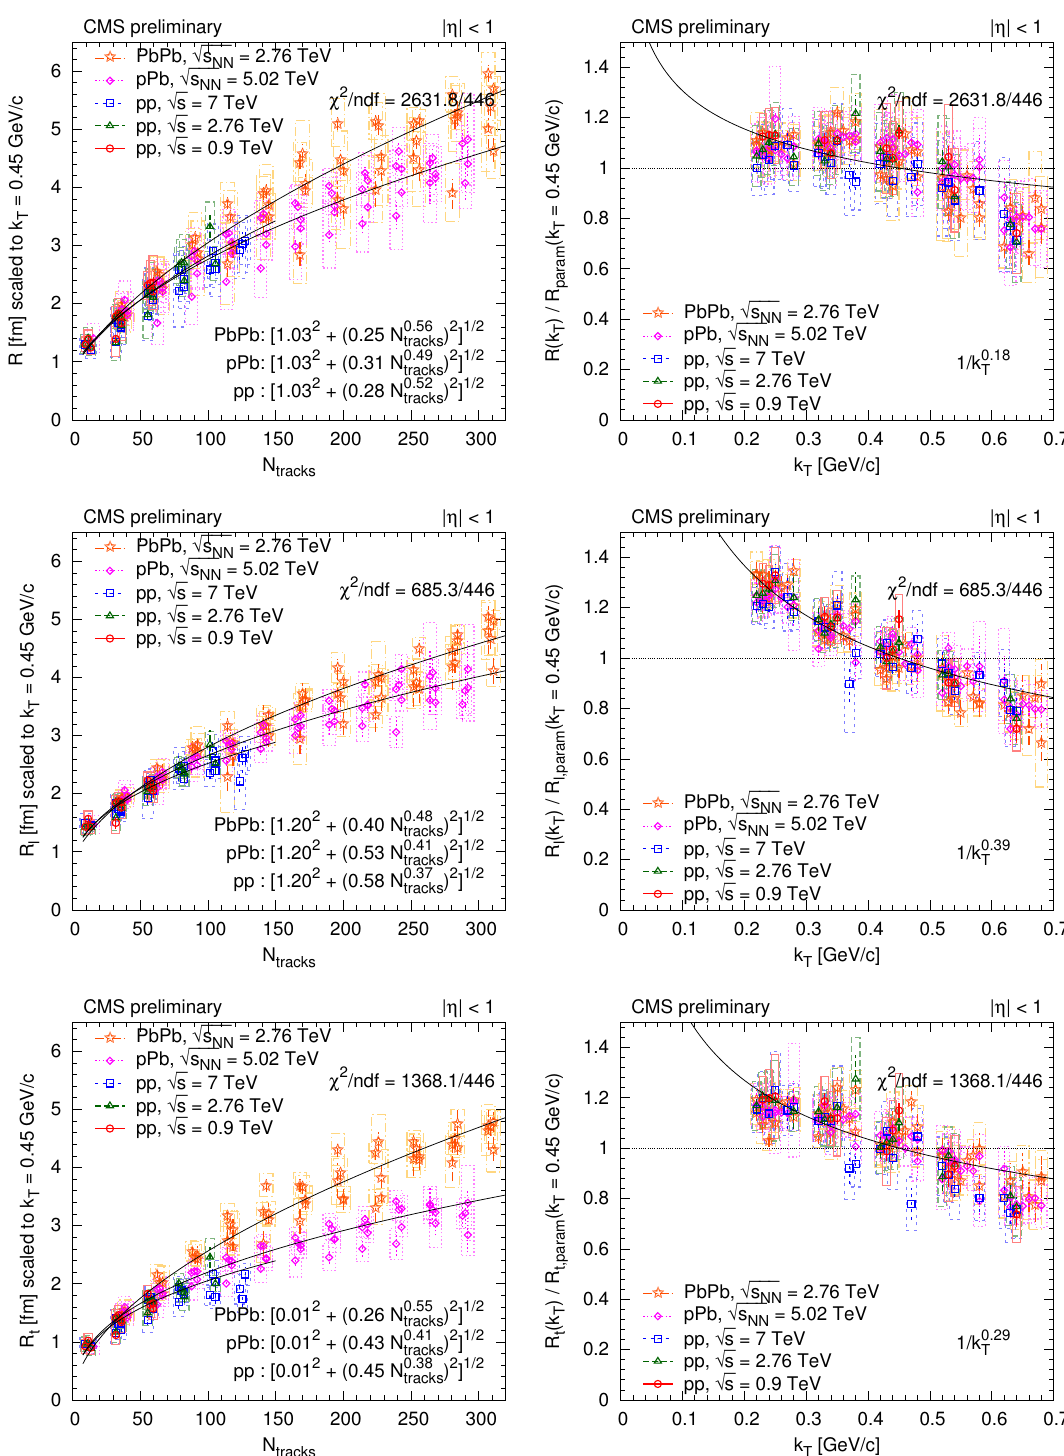
Figure 7. ( Left ) Radius parameters as a function of N tracks scaled to k T = 0.45 GeV/ c with the help of the parametrization R param (Equation 5). ( Right ) ratio of the radius parameter and the value of the parametrization R param (Equation 5) at k T = 0.45 GeV/ c as a function of k T (points were shifted left and right with respect to the center of the k T bin for better visibility). Upper row: R from the one-dimensional ( q inv ) analysis. Middle row: R l from the two-dimensional ( q l , q t ) analysis. Bottom row: R t from the two-dimensional ( q l , q t ) analysis. Fit results are indicated in the figures [8]; for details, see